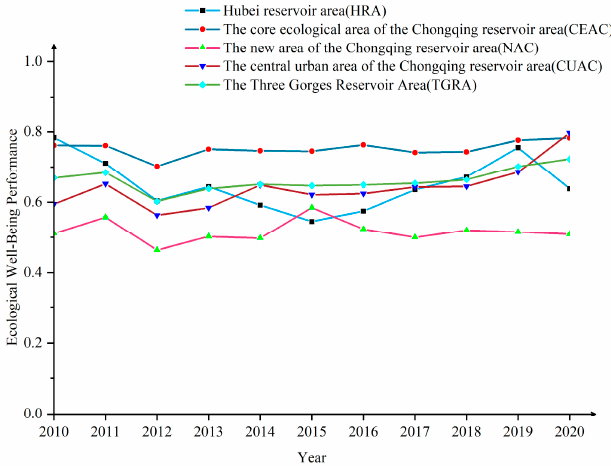
Figure 3. The trend of EWP in the TGRA, 2010–2020. For the four major regions, CEAC > HRA > CCC > NAC, with mean values of 0.752, 0.651, 0.642, and 0.517, respectively. Among them, CEAC is significantly higher than other regions, consistent with its excellent ecological environment, low energy consumption, and low pollution. The long-term position of NAC at the bottom of the list, showing an inverted “V” structure, may be related to the fact that the NAC took over a large number of relocated industries in the early period, which led to a rapid increase in GDP and boosted the local EWP. Then, as energy consumption and pollution emissions intensified and economic growth slowed down, the local EWP experienced a significant decline. Unlike the three regions in Chongqing, the HRA shows a rapid decline and a rapid rise, probably due to the low level of economic development in the HRA, which was still in the early stage of industrialization before 2015. The rapid development of industry brought high energy consumption and pollution, which led to the decline in EWP. As industrialization entered the middle and late stages, industrial energy consumption and pollution decreased, per-capita GDP increased significantly, the ecological environment improved, and the EWP gradually rose. Finally, from the number of different levels of EWP (Figure 4), the 26 counties (districts) of the TGRA show an olive shape, i.e., there are few excellent and low-performance counties (districts). The number of relatively low, relatively high, and high counties (districts) accounts for approximately 94% of the total, which again indicates that the overall level of EWP in the TGRA is low and still needs further improvement.